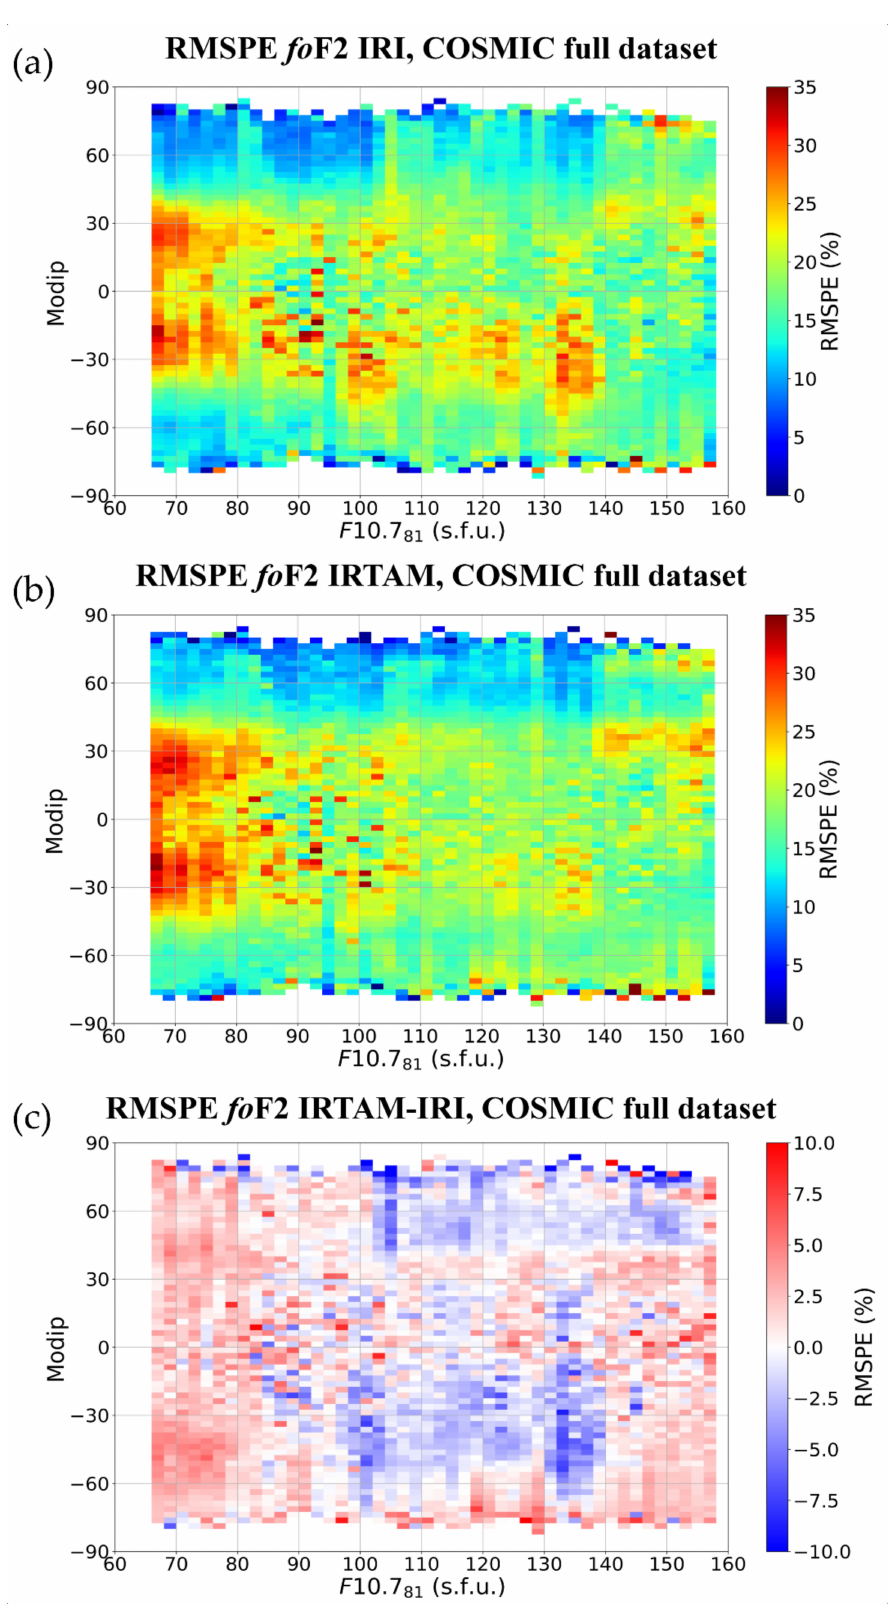
Figure 23. Same as Figure 21 but in this case data were binned as a function of the F10.7 81 solar activity index (two s.f.u.-wide bins) and modip (2.5 ◦ -wide